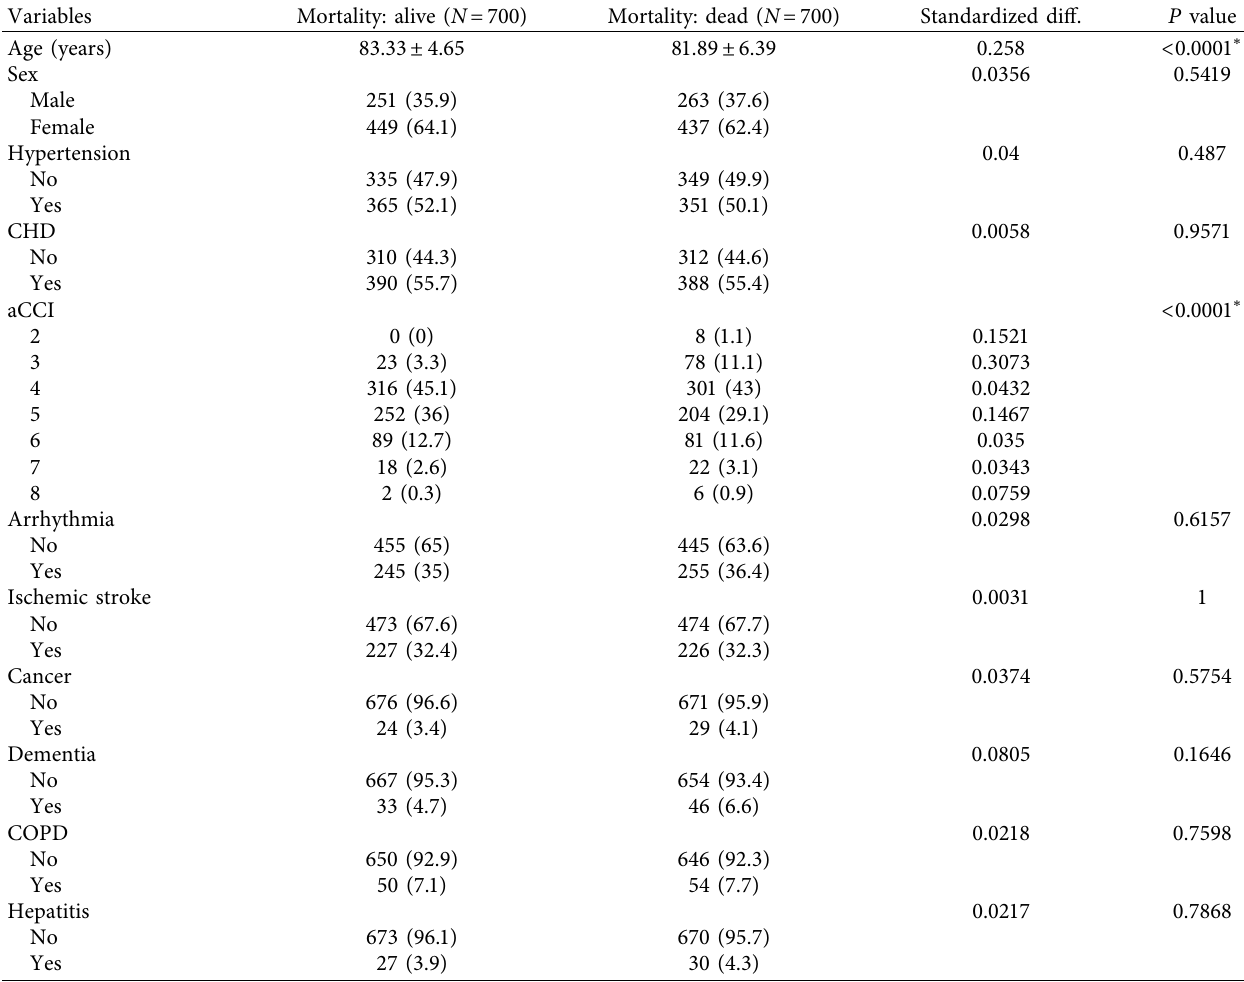
Table 6: Te balance test of PSM ( N �